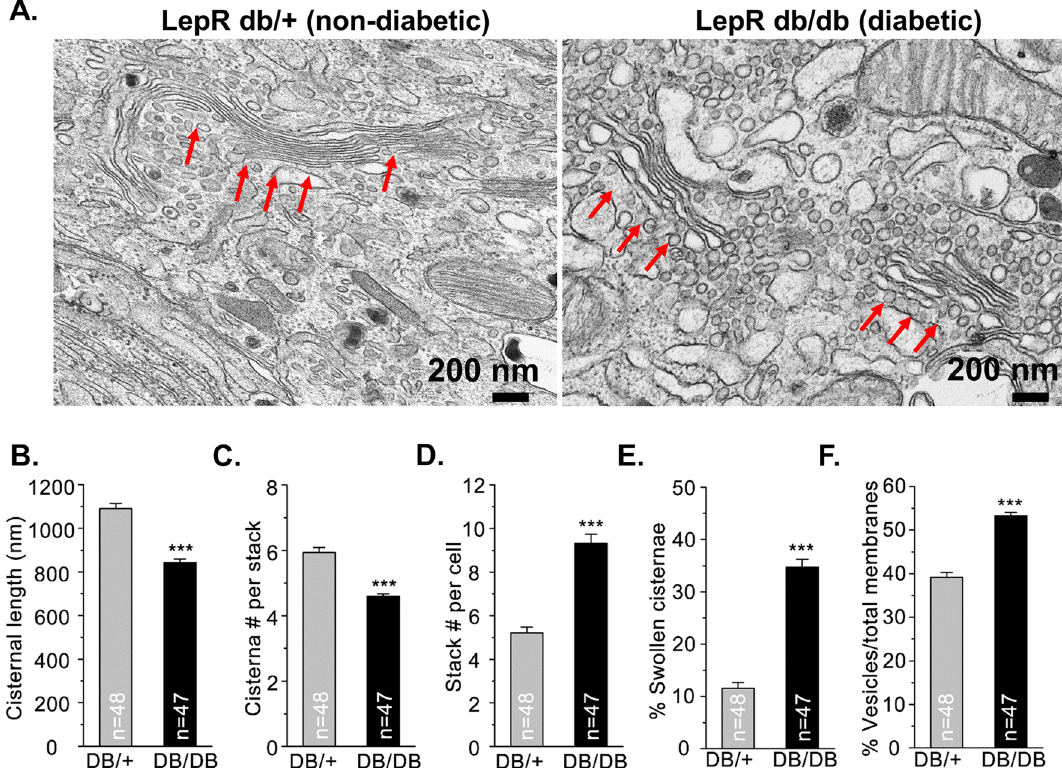
Figure 7. Alterations in Golgi morphology in a rodent model of islet dysfunction. Islets isolated from 10 to 14 wk old C57BLKS/J db/+ versus db/db were examined for ultrastructure by transmission electron microscopy (n = 3 mice per genotype). β-cells were identified morphologically by the presence of insulin granules. ( A ) Representative micrographs highlighting Golgi stacks (red arrows) are shown. Images were quantified for cisternal length ( B ), cisterna number per stack ( C ), Golgi stacks per cell ( D ), swollen cisternae ( E ), and degree of vesiculation ( F ). Number of images analyzed per genotype is listed. ( B – F ) Data represent the mean ± S.E.M. * p < 0.05 by Student t